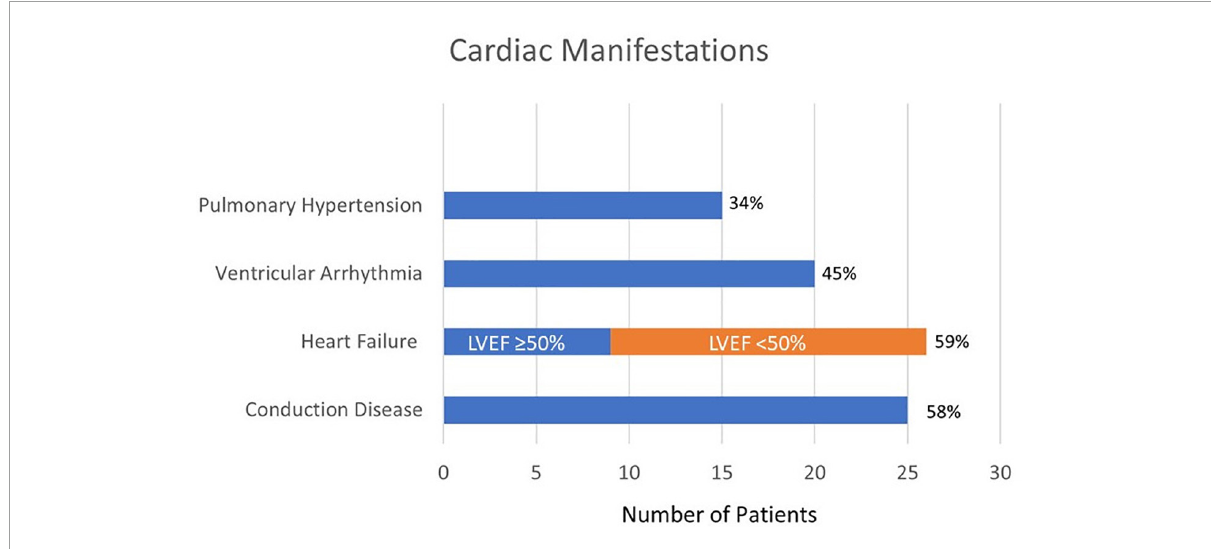
FIGURE1 Cardiac manifestations of patients with cardiac sarcoidosis ( N =